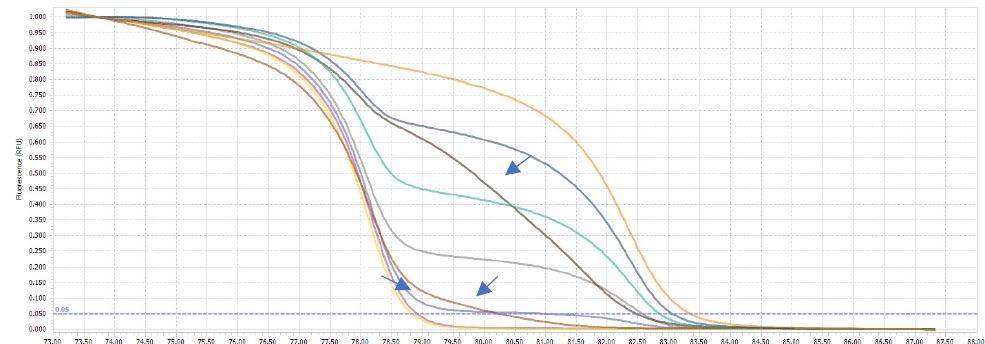
Figure 5. MS-HRM profile of ABCB1 promoter with representative samples (indicated by the arrows) of glioma patients: Methylated sample derived from a GBM patient #15 (dark brown melting curve across 25–75% methylated standards), mildly methylated samples derived from anaplastic astrocytoma patient #31 (light brown melting curve crossing the 10% methylated standard), and unmethylated sample derived from GBM patient #24 (light yellow sample following the unmethylated standard curve). Yellow melting curve—100% methylated standard; dark grey—75% methylated, green—50% methylated, light grey—25% methylated, blue—10% methylated, purple—unmethylated standard.